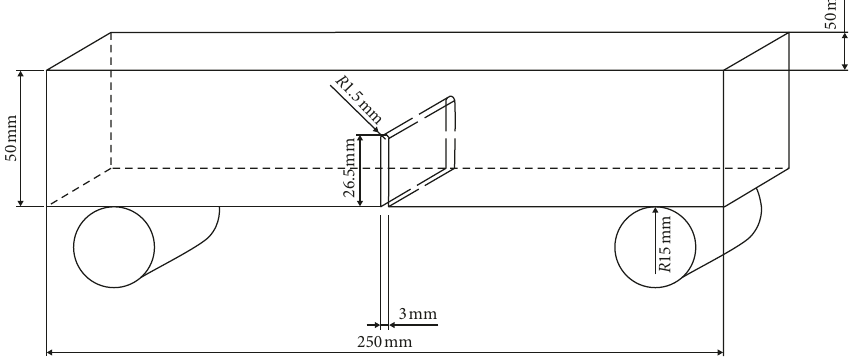
Figure 5: Geometry of three-point bending test specimens.